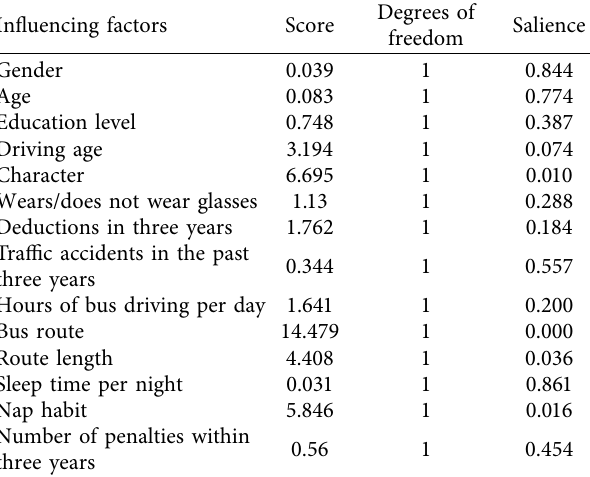
Table 17: Score test